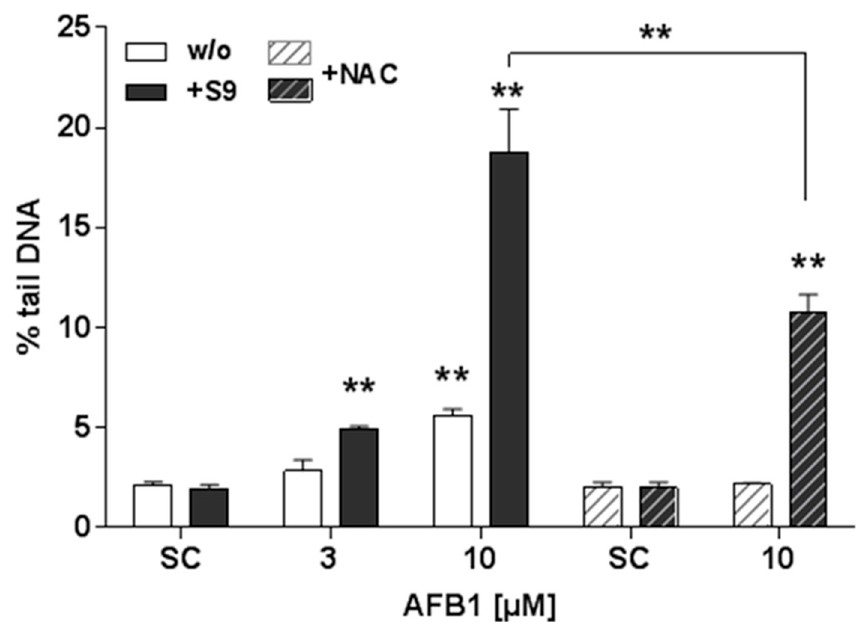
Figure 4. Effects of N-acetylcysteine (NAC) pretreatment on aflatoxin B1 (AFB1)-induced DNA damage. Peripheral blood mononuclear cells (PBMC) were exposed to AFB1 for 4 h without (white bars) or in the presence of S9 mix (black bars) without or with (hashed bars) NAC pre-treatment for 1 h. (SC: Solvent control = 0.1% DMSO). Data are means ± SD ( n = 3). Asterisks indicate statistically significant difference from the respective SC or between treatments indicated (** p ≤ 0.01).